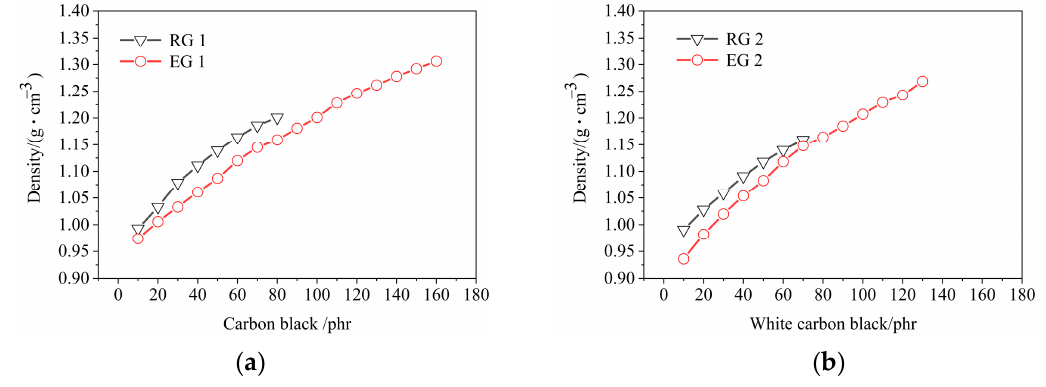
Figure 3. Effect of filler on the density of rubber samples. RG 1 and EG 1 were for SBR rubber mixtures; RG 2 and EG 2 were rubber mixtures based on NR rubber. ( a ) Effect of CB on the density of rubber samples; ( b ) Effect of WCB on the density of rubber samples.